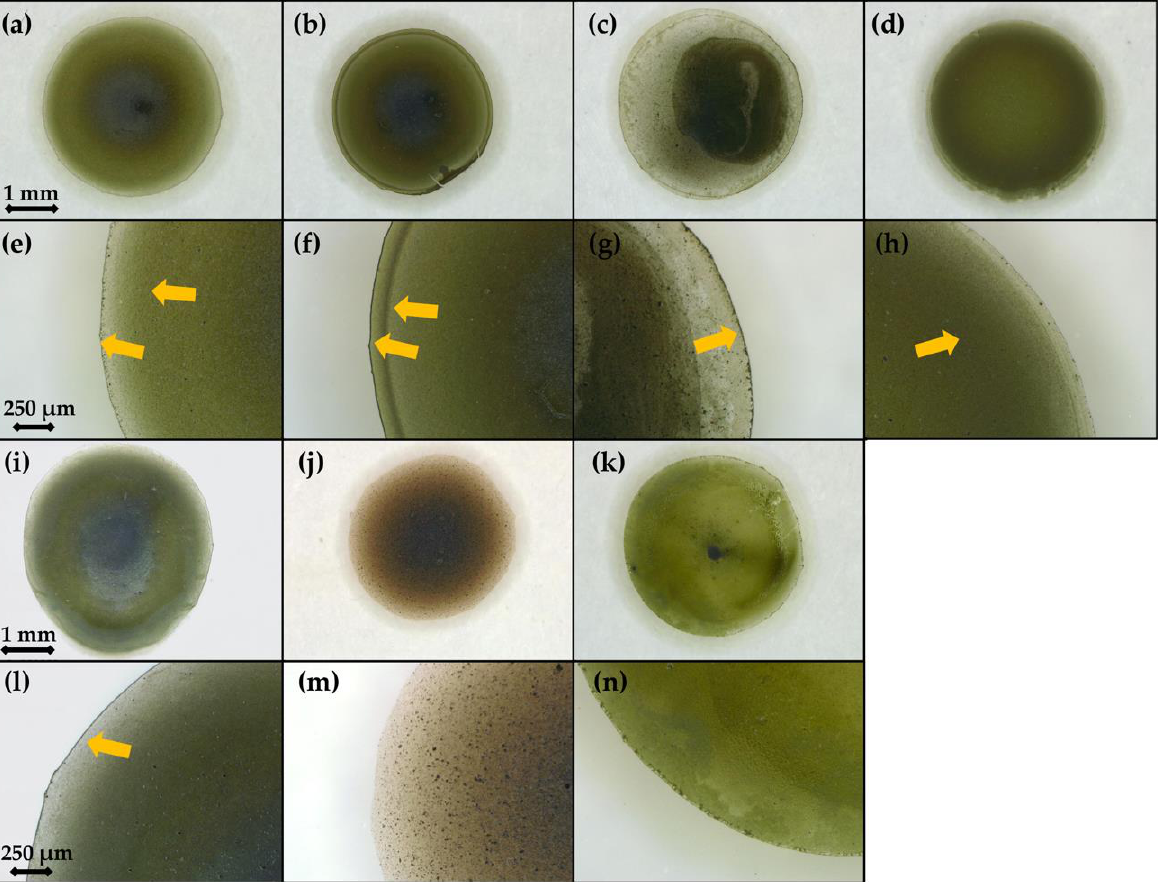
Figure 3. Microscope images of dry deposits: ( a , e ) CH_0.5/1%; ( b , f ) CH_0.5/5%; ( c , g ) CH_0.1/25%; ( d , h ) CH_1.0/25%; ( i , l ) CH_0.5/25%; ( j , m ) NAF_0.5; ( k , n ) PVP_1.0/25%. Yellow arrows indicate rings of accumulated particles.